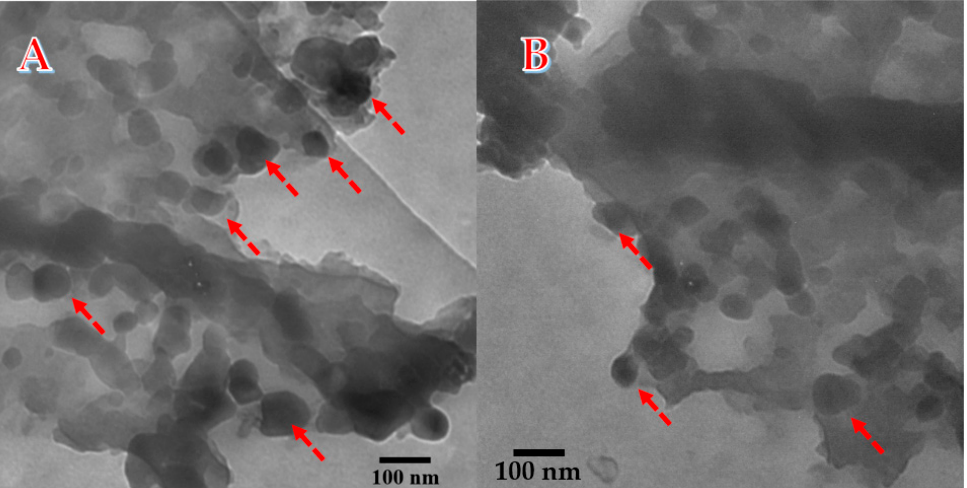
Figure 6. TEM image for a powder produced from hydrothermal treatment using 3.0 M KOH at 150 °C for 6 h and calcined at 800 °C; ( A ) and 1.0 M KOH at 170 °C for 3 h and calcined at 600 °C; ( B ). The for 6 h and calcined at 800 ◦ C; ( A ) and 1.0 M KOH at 170 ◦ C for 3 h and calcined at 600 ◦ C; ( B ). The arrows point to the crystalline inorganic NPs. arrows point to the crystalline inorganic